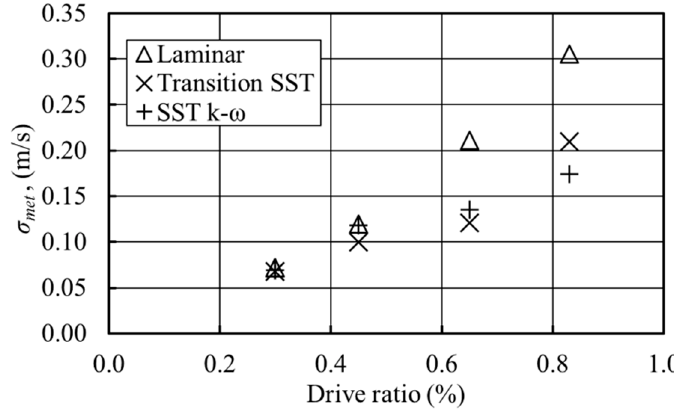
Figure 16. Plot of metric (cid:2026) (cid:3040)(cid:3032)(cid:3047) for laminar, transition-SST and SST k- ω models vs. the drive